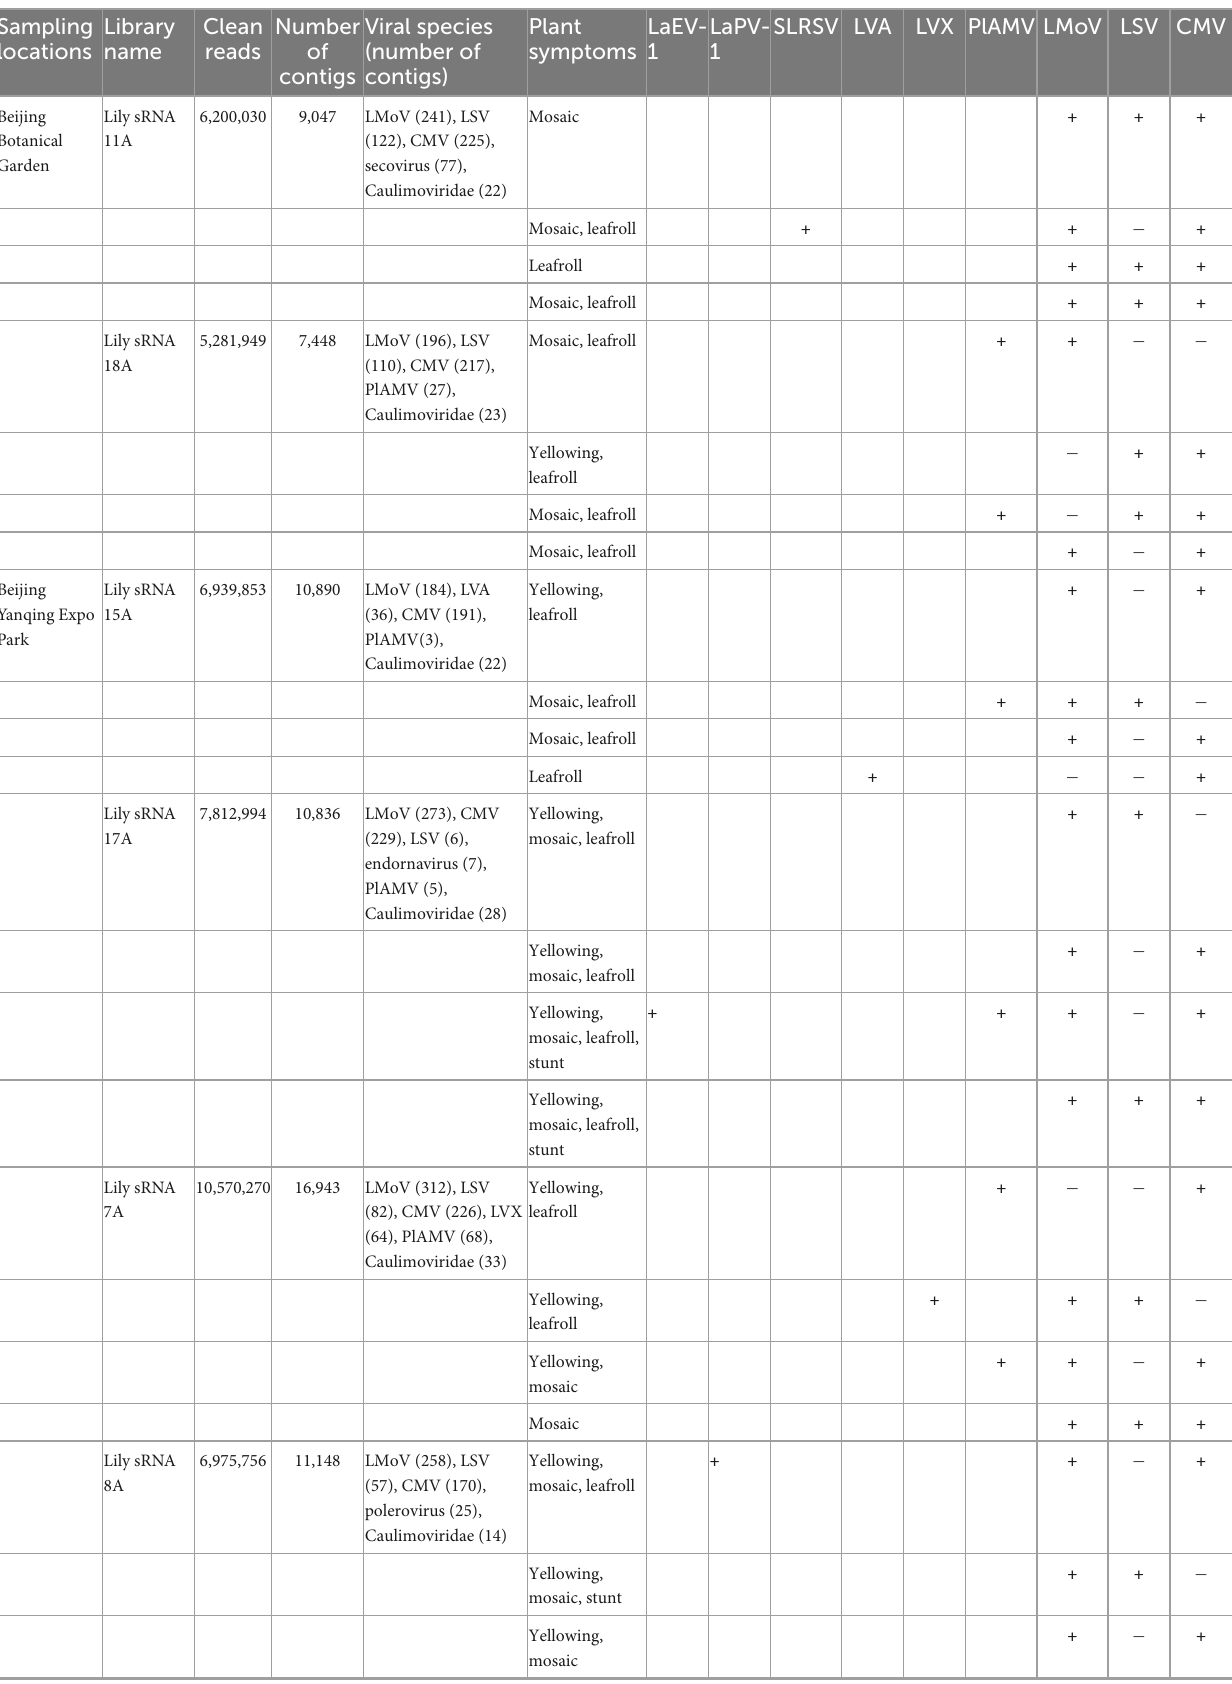
TABLE 1 The information of sRNA-seq and candidate viruses in each sequenced lily plant. Sampling Library locations